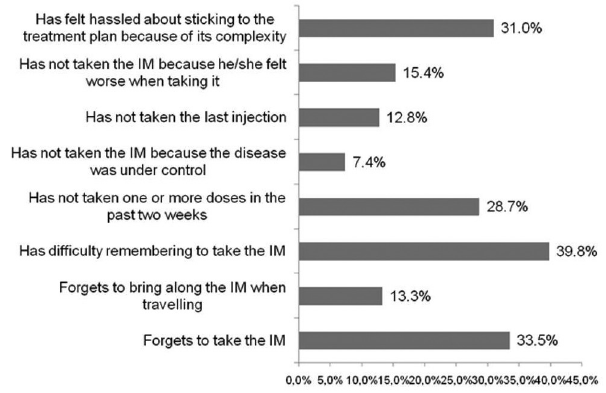
FIGURE 1 - Frequency of positive answers in Morisk 8-item scale TABLE III – Association between adherence and the variables adjusted in the logistic regression model divided into blocks. Ceará,